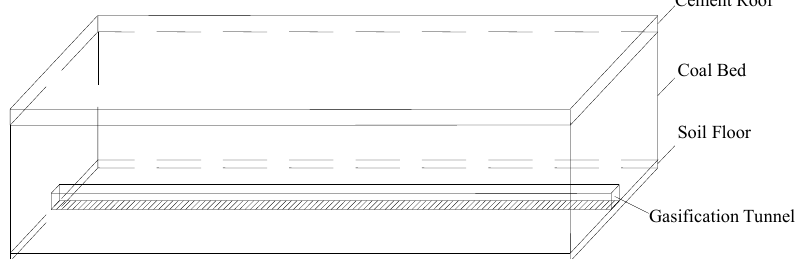
Figure 3. Schematic diagram of coal bed layout.